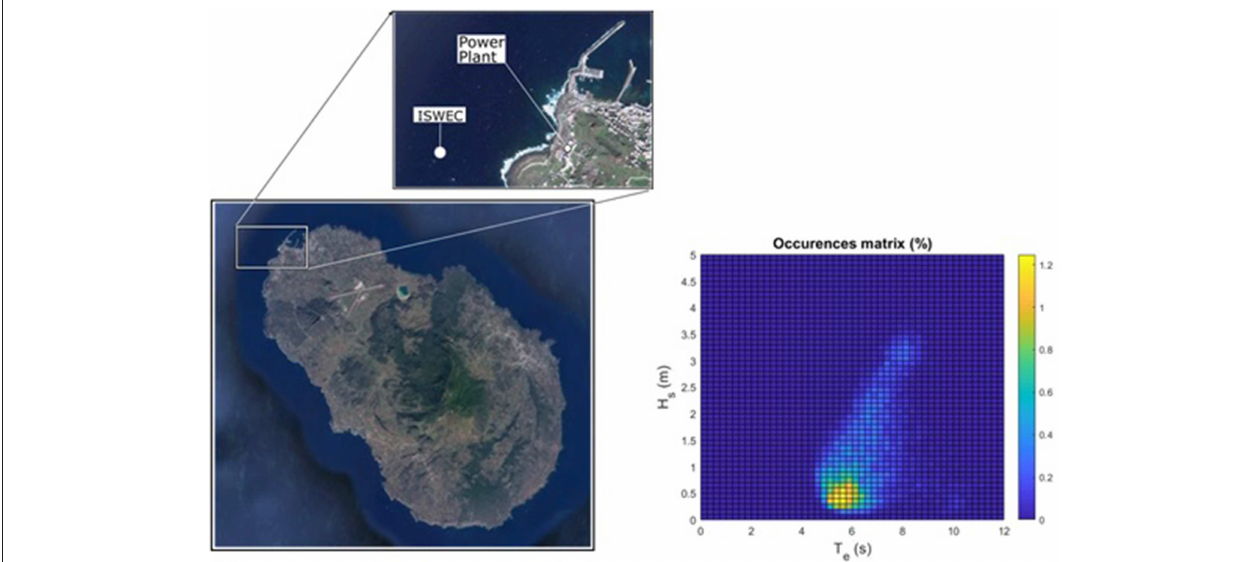
FIGURE 2 | ISWEC deployment site (Left) and Pantelleria’s Scatter Table (Right)